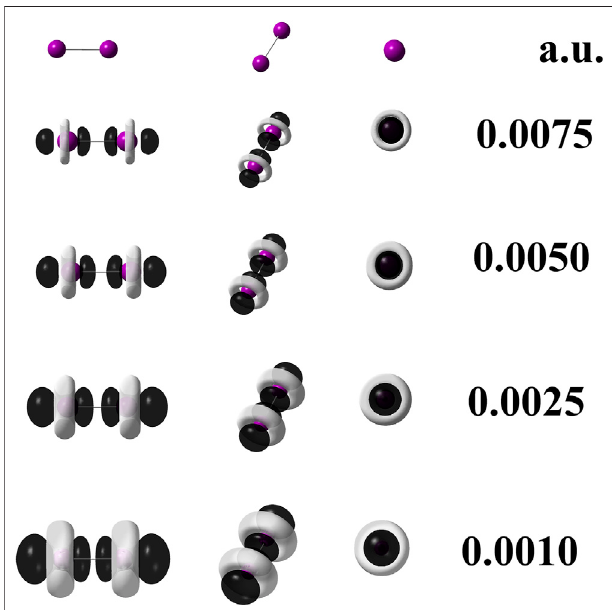
FIGURE 2 | Dual descriptor (DD) of diiodine computed at the M06 – L/ UGBS1p//M06 – L/def2-QZVPPD at different isovalues given in atomic units. To use Eq. 6 , the following densities of frontier molecular orbitals were employed: | Ψ LUMO ( r )| 2 , | Ψ HOMO ( r )| 2 , and | Ψ HOMO − 1 ( r )| 2 . Purple spheresstandforiodineatoms,black – coloredlobesrepresentpositivevalues of DD ( f (2) ( r ) > 0); white – colored lobes correspond to negative values of DD ( f (2) ( r ) < 0).